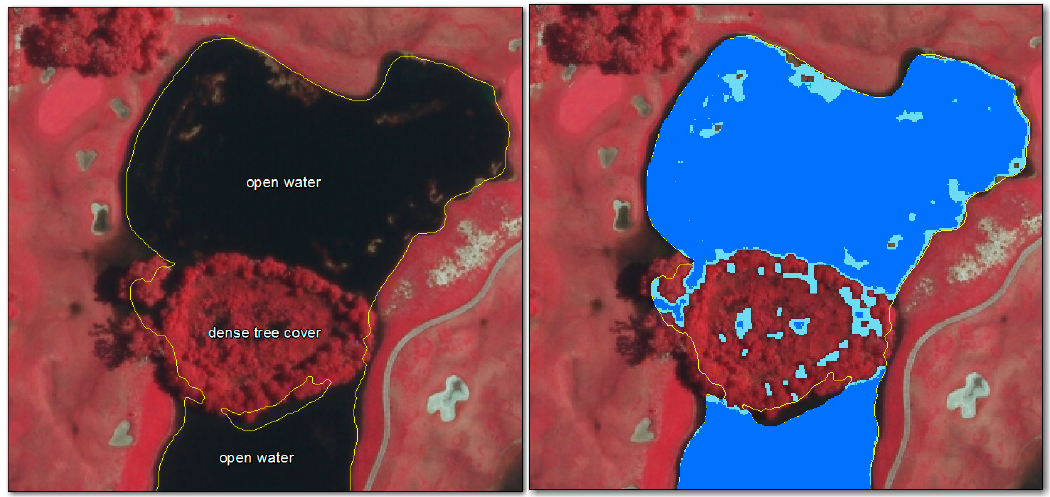
Figure 6. Image analysis results ( right , indicated in blue) for the fCIR image ( left ) in obscured and unobscured areas as compared to Tropical Storm Debby modeled floodplain (yellow outline) (scale ~ 1:3000).